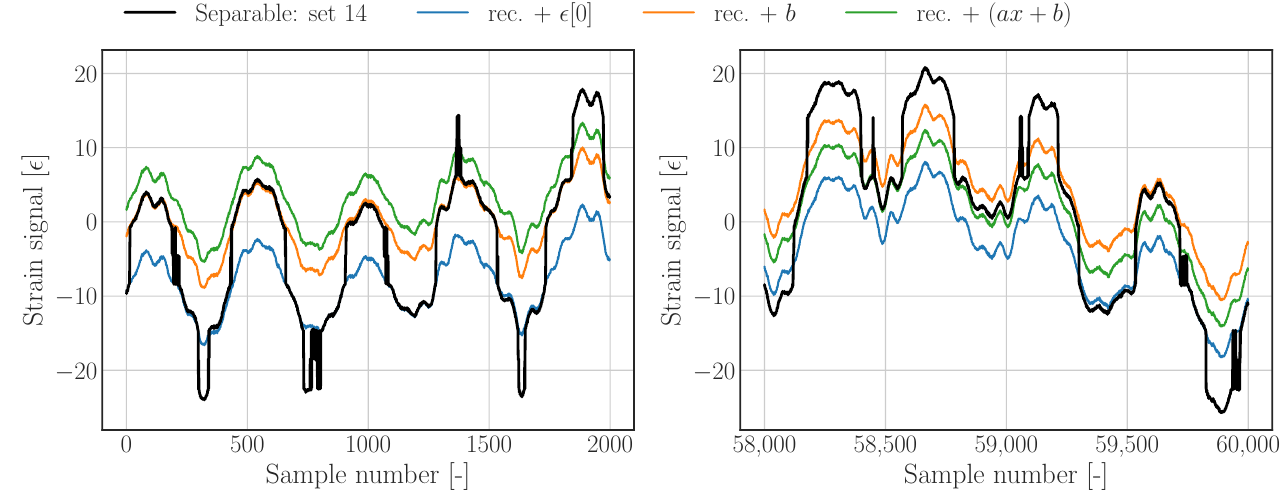
Figure 8. Raw and reconstructed time series with calibrated mean value using all samples as calibration subset.